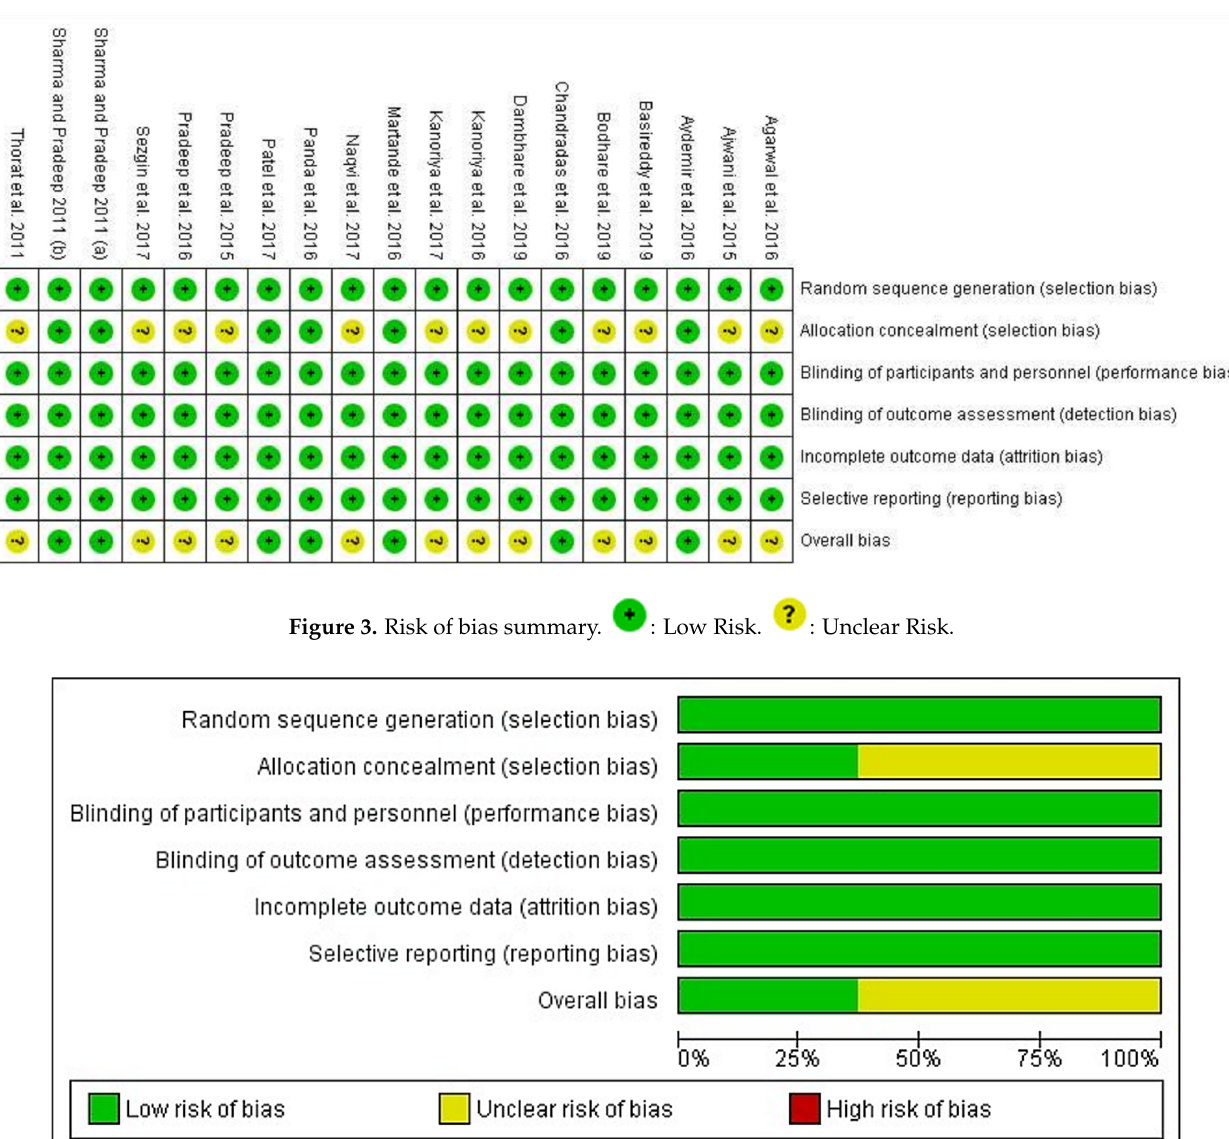
Figure 4. Risk of bias shown as a percentage (%).